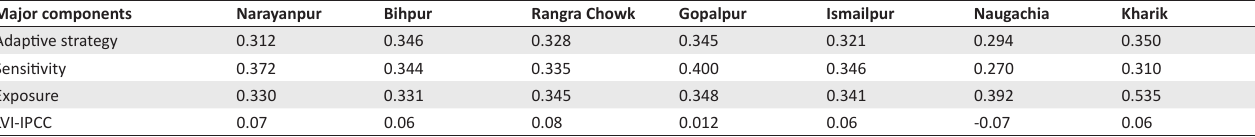
FIGURE 5: Vulnerability spider diagram of the major components of the livelihood vulnerability index for district blocks. (a) Narayanpur, (b) Bihpur, (c) Rangra Chowk, (d) Gopalpur, (e) Ismailpur, (f) Naugachia, (g) Kharik and (h) total. TABLE 4: Intergovernmental Panel on Climate Change livelihood vulnerability index (livelihood vulnerability index-Intergovernmental Panel on Climate Change) for district blocks. Major components